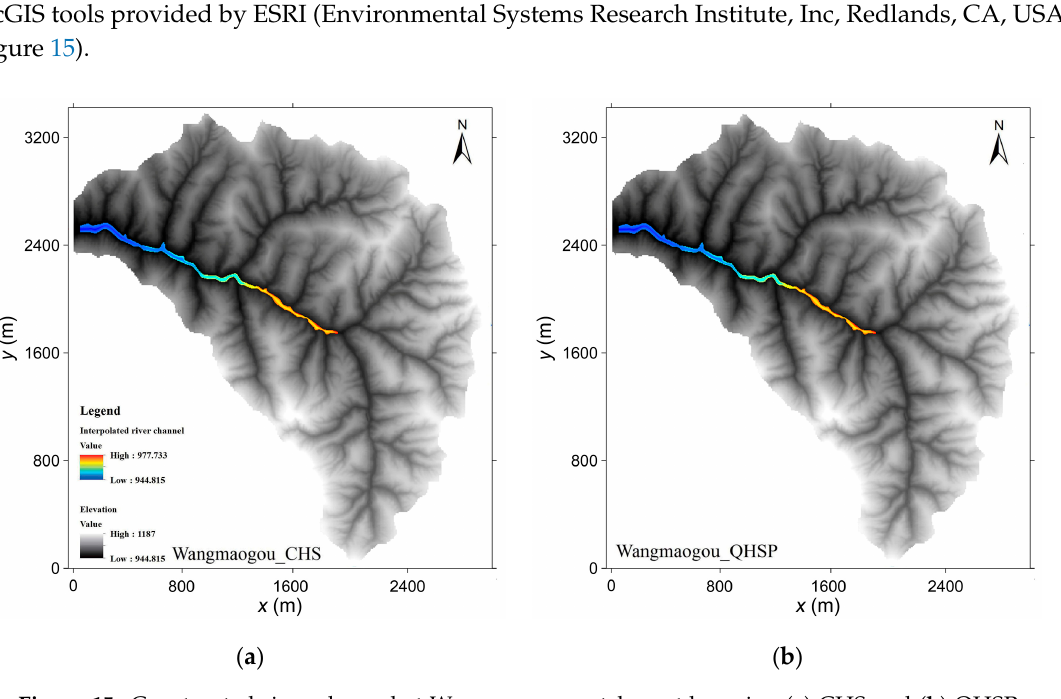
Table 4. The net rainfall process.